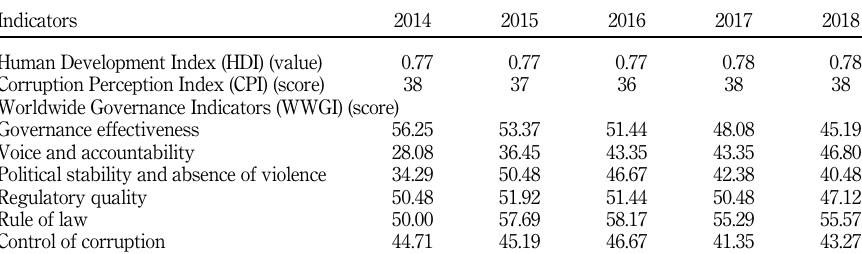
Table 1. Sri Lanka ’ s scores in Human Development Index, Corruption Perception Index, and World Bank ’ s Worldwide Governance